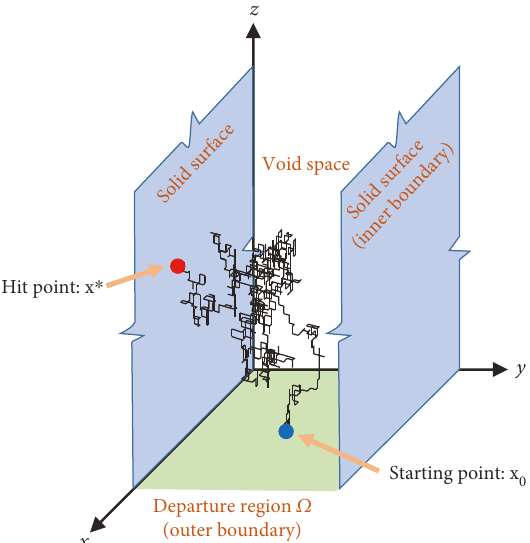
Figure 1: A diagram of random walk in void space. The outer boundary is the face of the medium; the inner boundary consists of the void-solid interface. Black line shows the path of a random walk